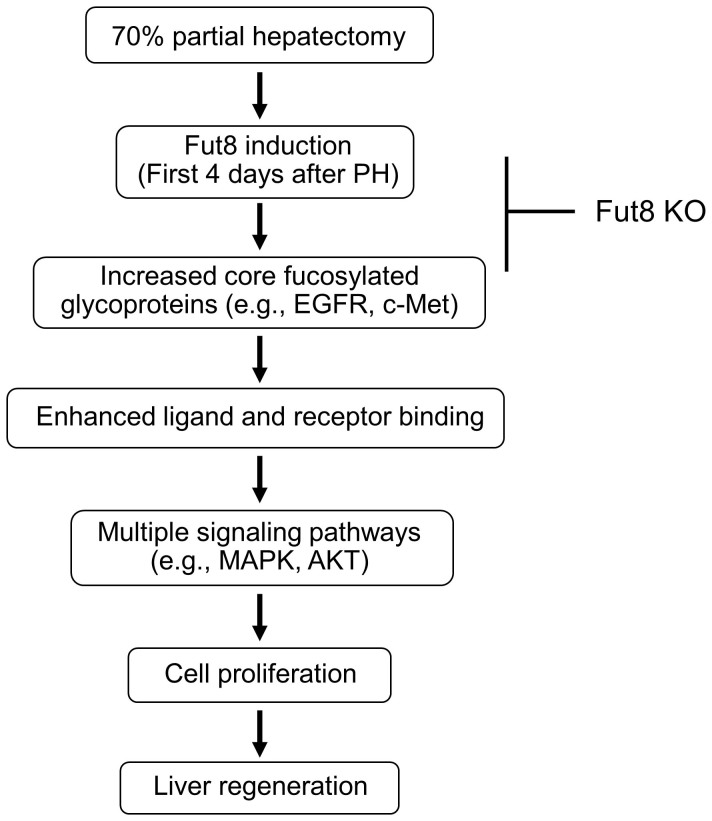
Proposed molecular mechanisms for the delayed liver regeneration in Fut8−/− mice.It is well known that the 70% partial hepatectomy could activate several cell proliferation associated signaling pathways including Ras/MAPK signaling, c-Met signaling, and Akt/mammalian targets of rapamycin (mTOR) signaling, which up-regulate the cell proliferation, and consequently lead to the restoration of liver. Loss of core fucosylation on growth factor receptors such as EGFR and c-Met may alter their conformation and impair their ligand binding, thereby inhibiting their downstream signalings, and ultimately suppressing the cell proliferation. Overall, a loss of Fut8 gene results in a decrease in liver regeneration.